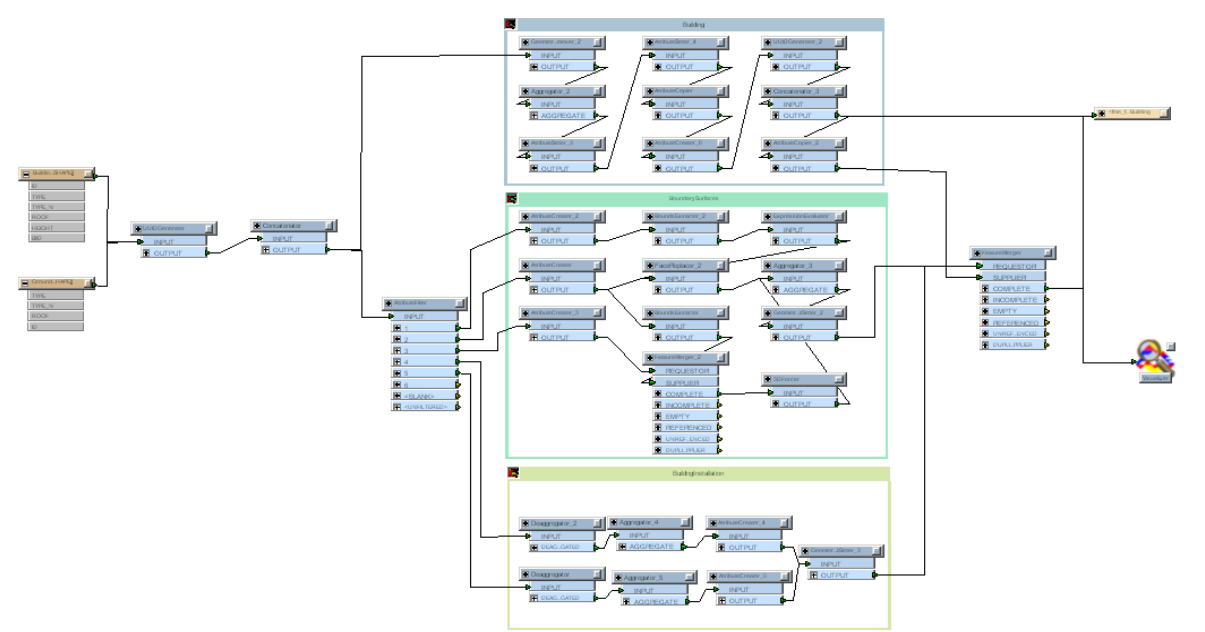
Figure 5.2: Conversion from ESRI PolygonZ shape file to CityGML data